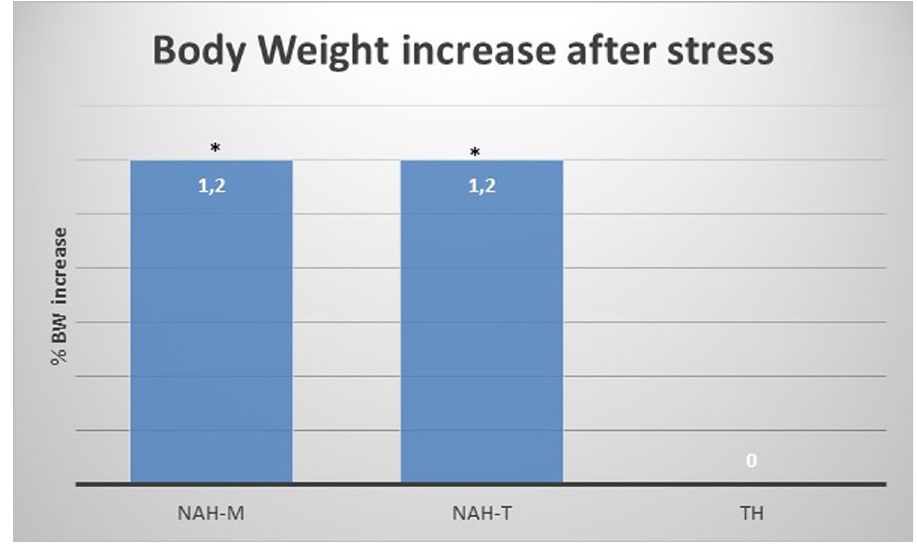
Fig 6. Body weight. Difference in percentage of body weight gain among groups. NAH-T and NAH-M were associated with an increase in body weight with respect to TH, suggesting that Non-aversive handlings might protect mice from the lack of weight gain seen in TH group (H of KW = 6.886 p = 0.032, Eta 2 18%).